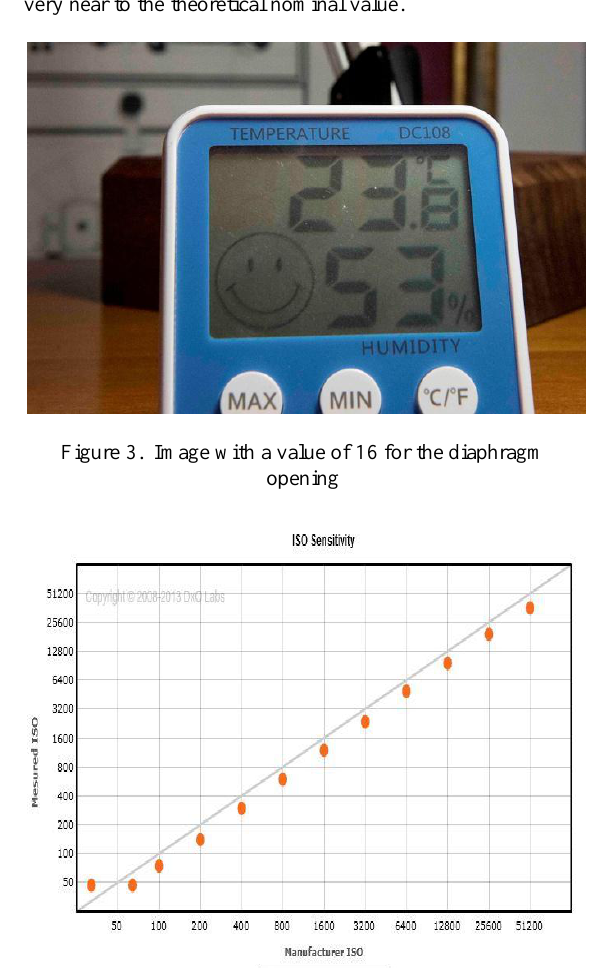
Figure 2. Image with a value of 2 for the diaphragm opening Shooting speed has always been superior to 1/60 of second (one sixtieth of second), although the cameras have damping systems of the vibrations produced by the shoot. It is apparent from Figure 4 that the ISO sensitivity of the camera sensor used in the described experience has been fixed to the value of 64 ISO, a nearly ideal value for the exposition, a value very near to the theoretical nominal value.